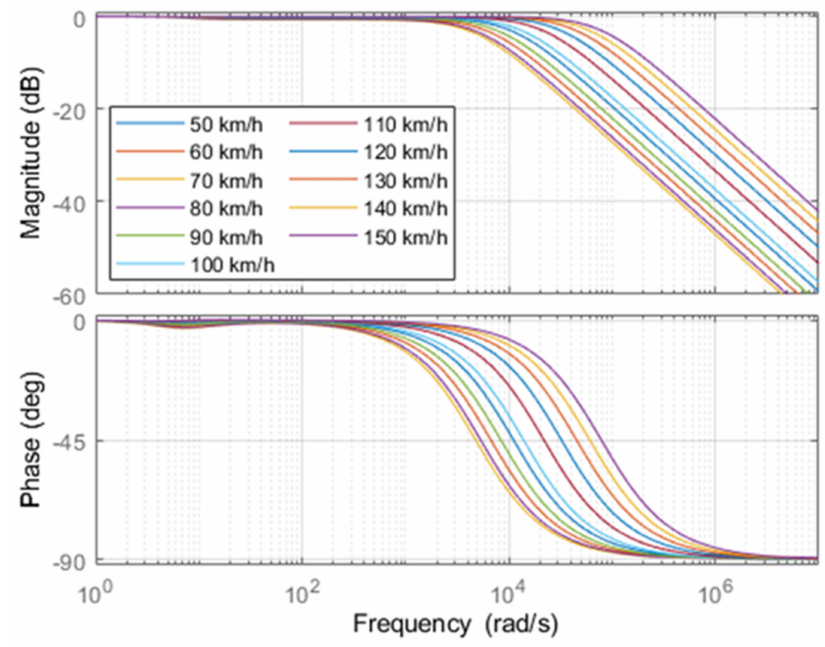
Figure 11. Bode diagrams for PID controller using Naslin’s